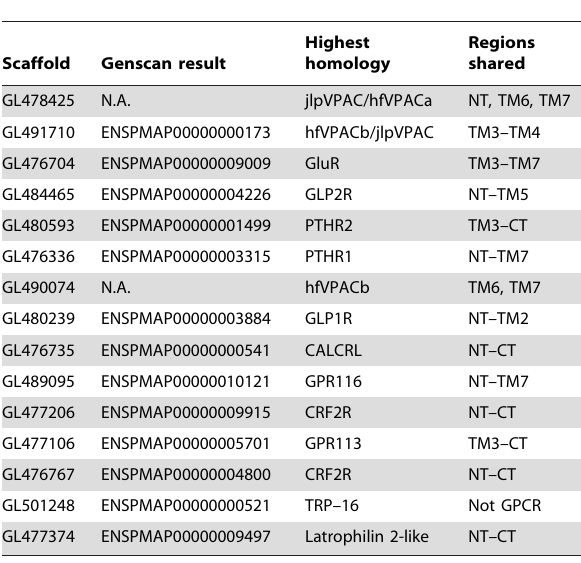
Table 1. Sea lamprey scaffold search